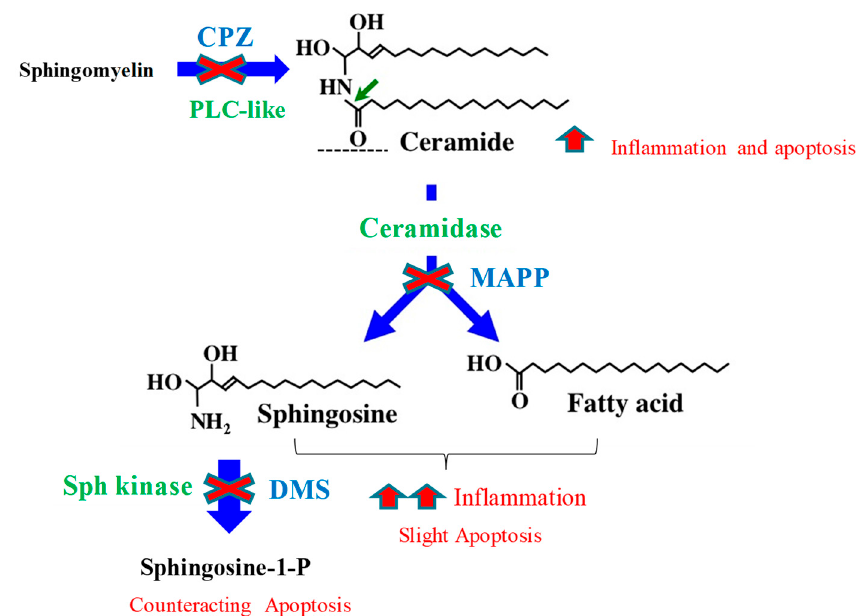
Figure 9. E ff ect of the inhibitors used in the study on sphingolipid generation and on LDL( − )-induced inflammatory and apoptotic actions. CPZ blocks sphingomyelin degradation, thereby decreasing Cer content and LDL( − )-induced cytokine release and apoptosis. MAPP blocks Cer degradation, leading to a decrease in Sph and NEFA generation, which seems to develop an essential role in inflammation, but a likely minor role in apoptosis. DMS blocks sphingosine-1-phosphate (S1P) generation, thus leading to an increase in the apoptotic e ff ect of LDL( − ).